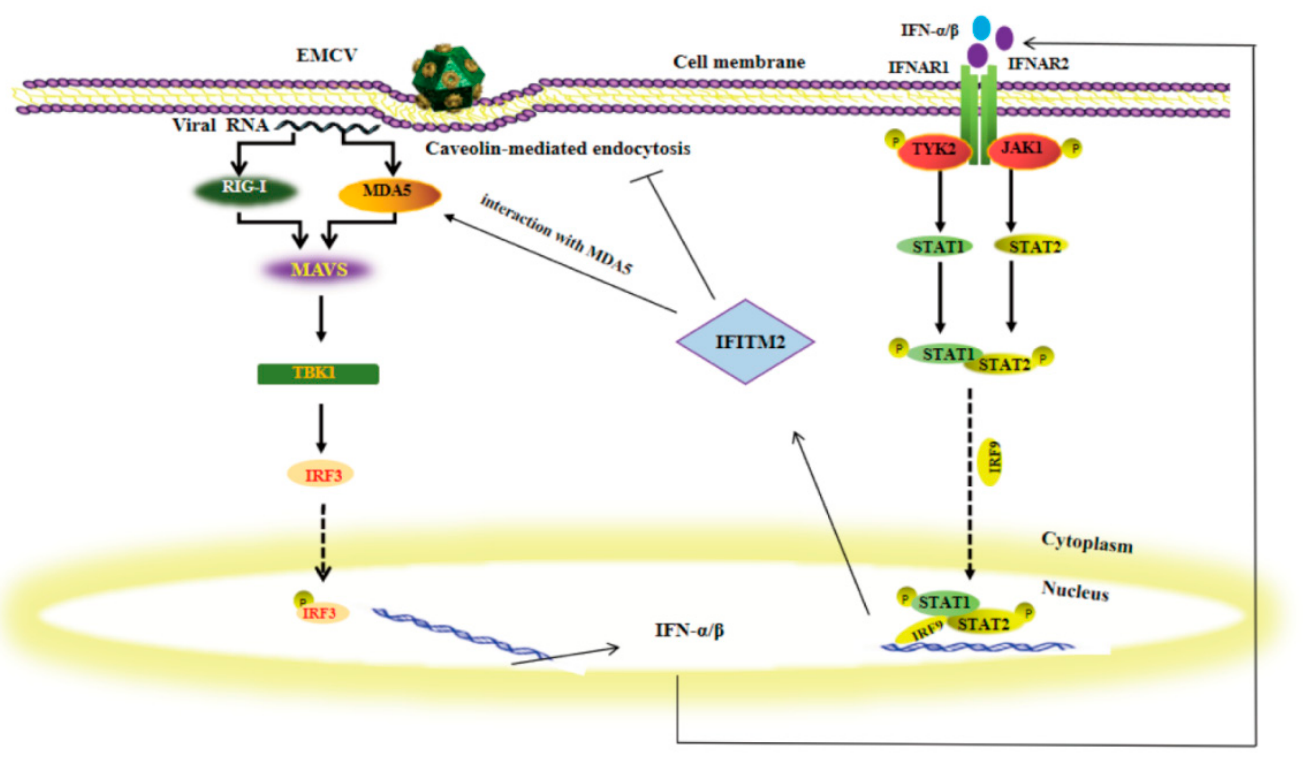
Figure 10. EMCV infected HEK293 cells via the caveolin − mediated endocytosis pathway. When the viral nucleic acid is exposed to the cytoplasm, it is recognized by pa tt ern recognition receptor MDA5, which ampli fi es the signaling cascade and stimulates the host cell to produce type I IFN. Type I IFN binds to cell surface receptors and activates IFITM production via the JAK − STAT signal- ing pathway. IFITM presents an antiviral role in HEK293 cells during EMCV infection. Further study shows that IFITM2 could decrease caveolin − 1 expression and inhibit the virus entry process.